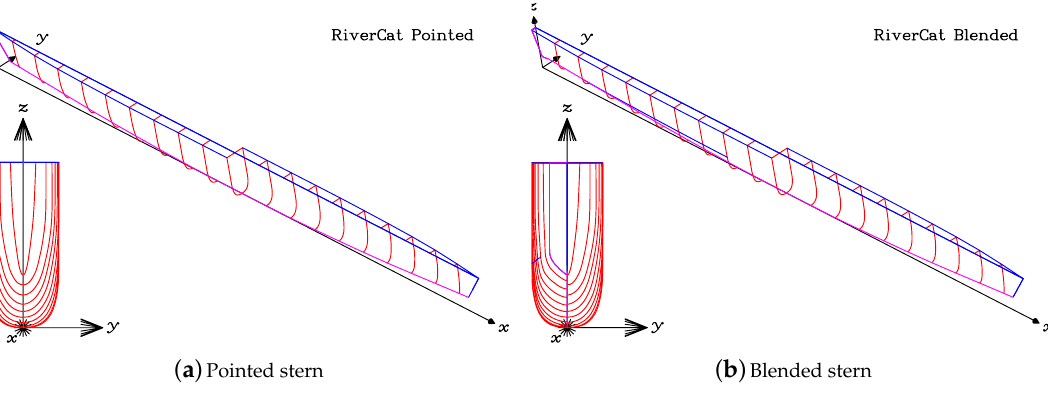
Figure 8. Transformations of the finalized RiverCat demihull.